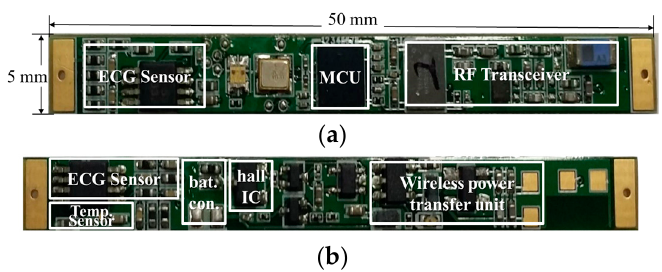
Figure 7. The developed system on a board (SoB) for ECG sensing, telemetry, and wireless power transfer (WPT) receiving: ( a ) Front and ( b ) back sides.